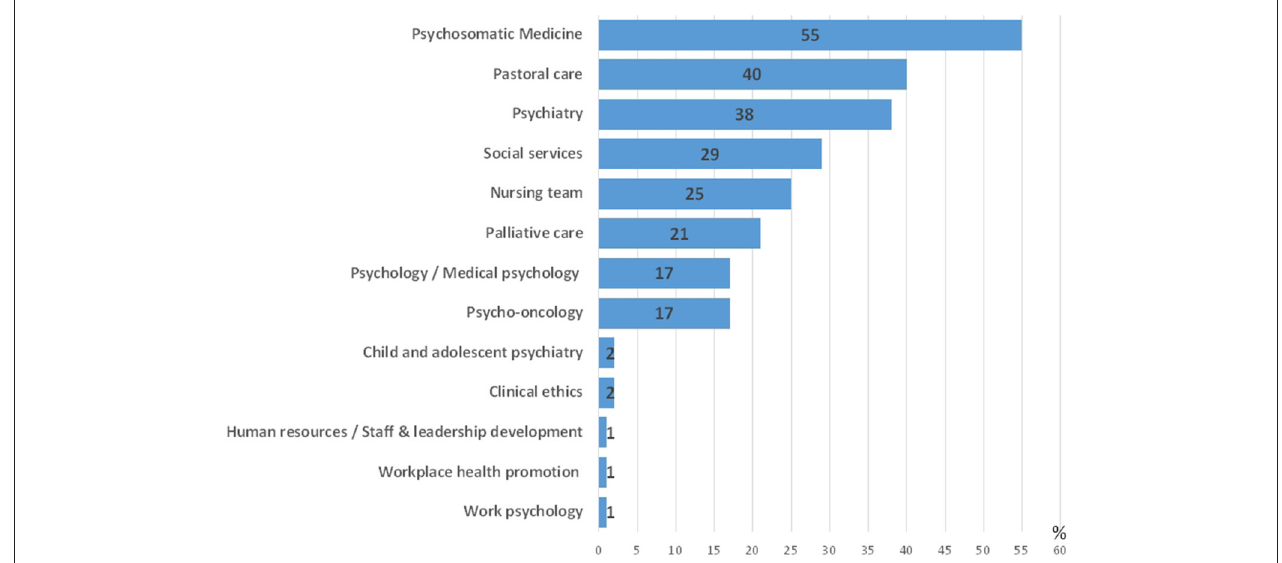
FIGURE 4 | Partners involved in cooperation structures for COVID-psyCare (relative frequencies, n = 77 CL services with COVID-psyCare, multiple answers possible).